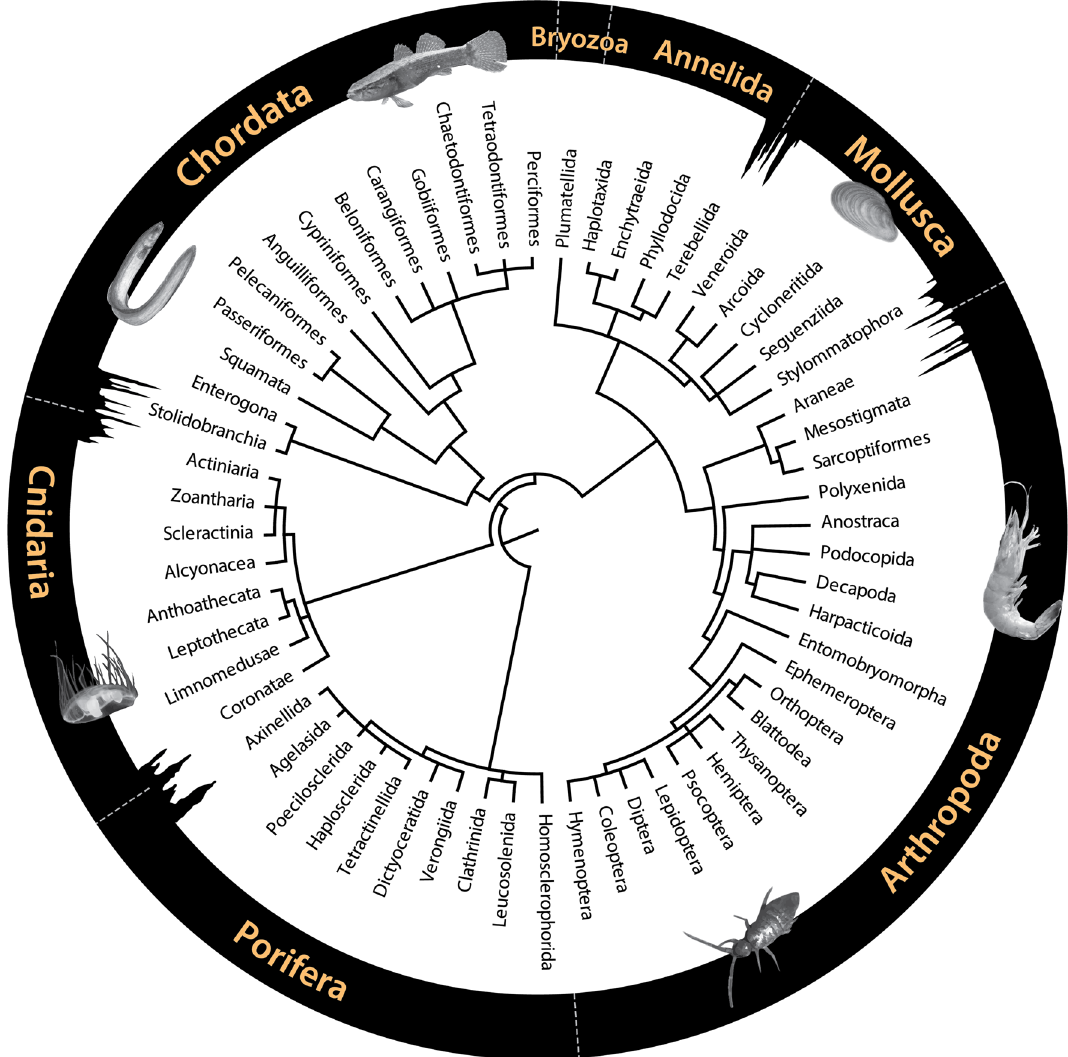
Figure 3. A total ordinal-level dendrogram of chordate, cnidarian, porifera, arthropod, mollusc, annelid and bryozoan taxa detected by multi-assay metabarcoding on 159 eDNA samples collected across Christmas